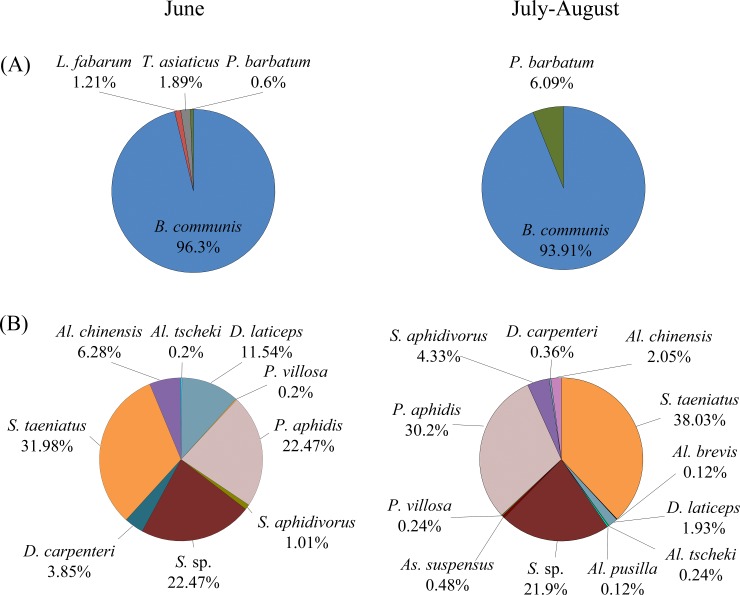
The cotton aphid primary parasitoid (A) and hyperparasitoid (B) diversity and composition in the seedling period (June) and the flowering period (July-August). Note: short name for the different primary parasitoid and hyperparasitoid species. Primary parasitoids: B. communis: Binodoxys communis; L. fabarum: Lysiphlebus fabarum; T. asiaticus: Trioxys asiaticus; P. barbatum: Praon barbatum. Hyperparasitoids: Al. brevis: Alloxysta brevis; Al. chinensis: Alloxysta chinensis; Al. tscheki: Alloxysta tscheki; D. carpenter: Dendrocerus carpenter; D. laticeps: Dendrocerus laticeps; P. aphidis: Pachyneuron aphidis; S. aphidivorus: Syrphophagus aphidivorus; S. sp.: Syrphophagus sp.; S. taeniatus: Syrphophagus taeniatus; P. villosa: Phaenoglyphis villosa; As. suspensus: Asaphes suspensus; Al. pusilla: Alloxysta pusilla.